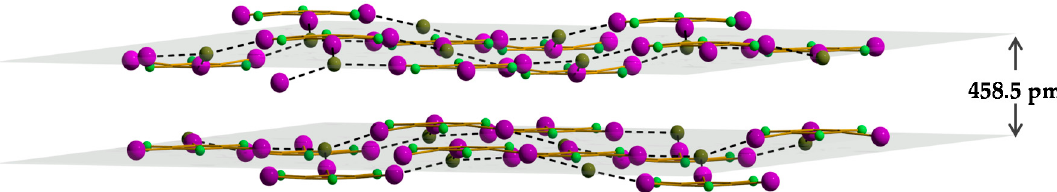
Figure 3. Two supramolecular anionic layers in the crystal structure of 3d . Semitransparent planes are the mean square planes through the anions of a layer. Color codes as in Figure 1; brown lines are the covalent bonds; black dotted lines are XBs; Et 4 P + cations have been omitted for clarity.